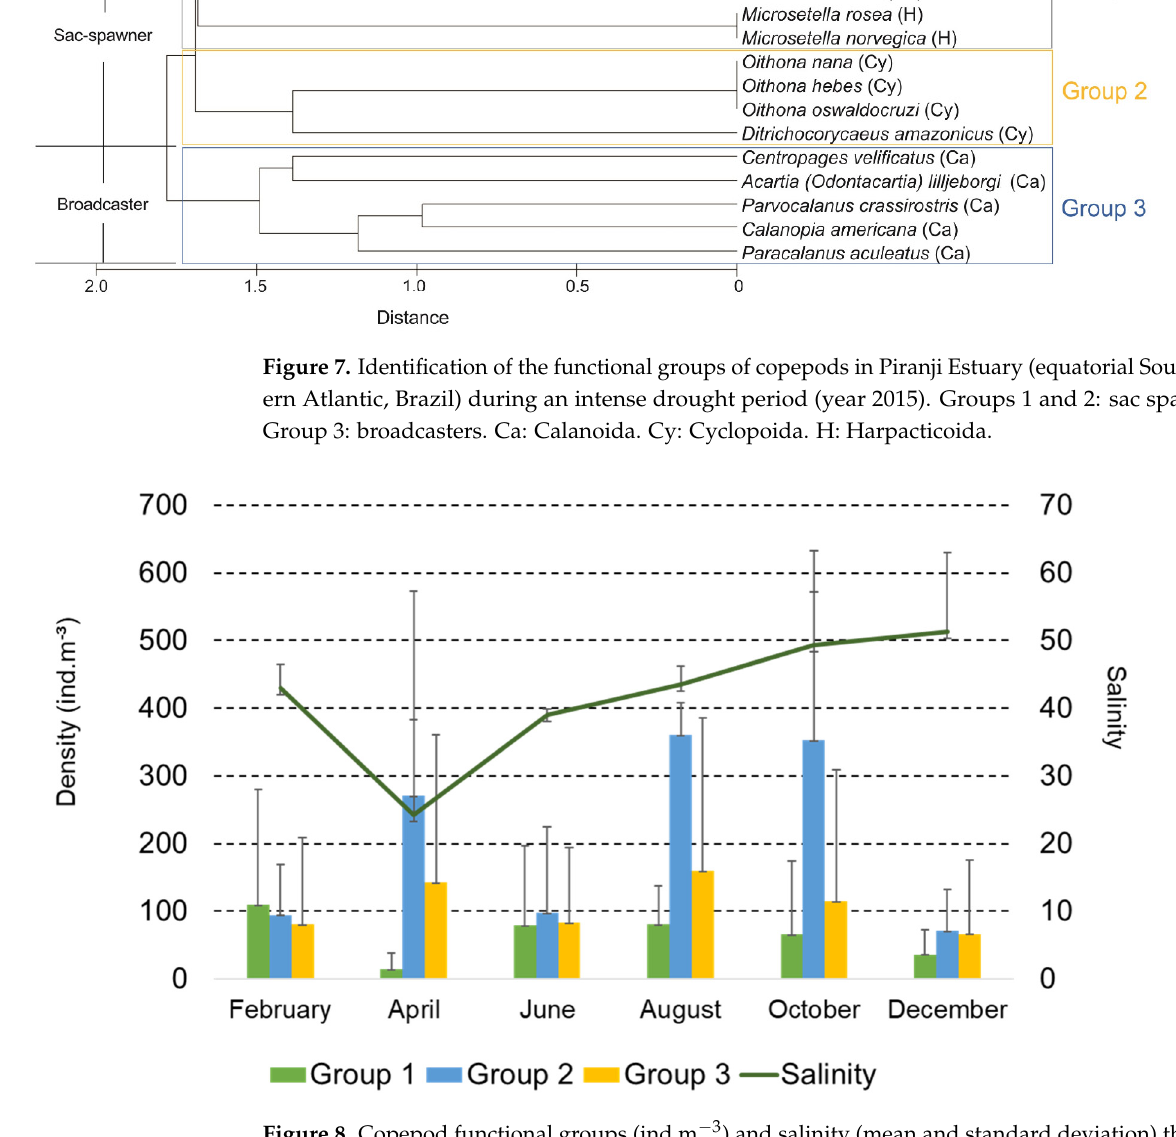
Figure 8. Copepod functional groups (ind.m − 3 ) and salinity (mean and standard deviation) throughout the studied months in Piranji Estuary (equatorial Southwestern Atlantic, Brazil, 2015).